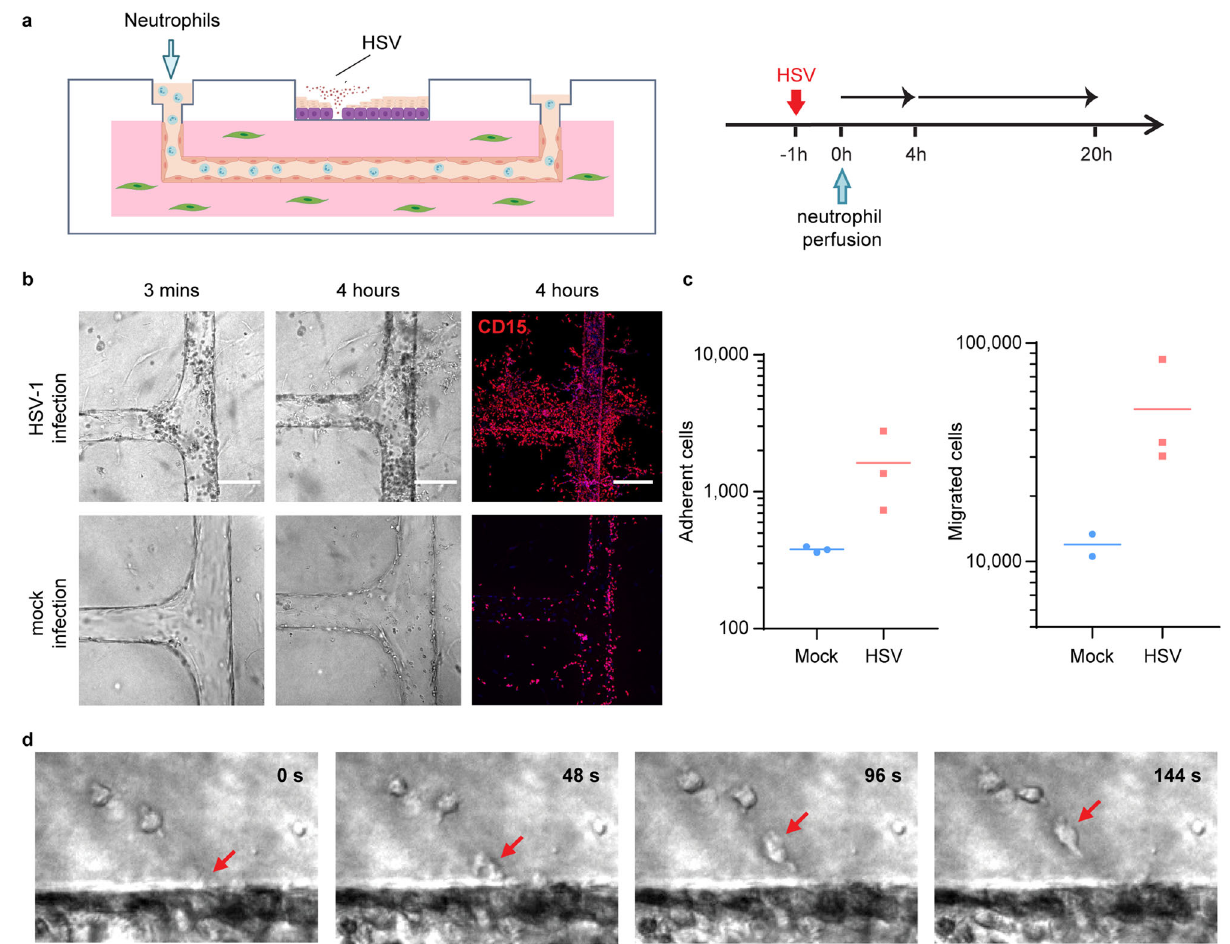
Fig.4|TransmigrationofneutrophilsinHSV-infectedskin-on-chip.a Schematic of epidermal HSV infection and neutrophil addition to the skin-on-chip. Neu- trophils were perfused through the microvascular network 1h after the epidermis wasinfectedwithHSV-1K26(10 6 PFU).Theskin-on-chipwas fi xedeither4hor20h post neutrophil perfusion. b Rapid neutrophil response to HSV infection in the epidermis. Bright fi eld and maximum intensity projection confocal images of